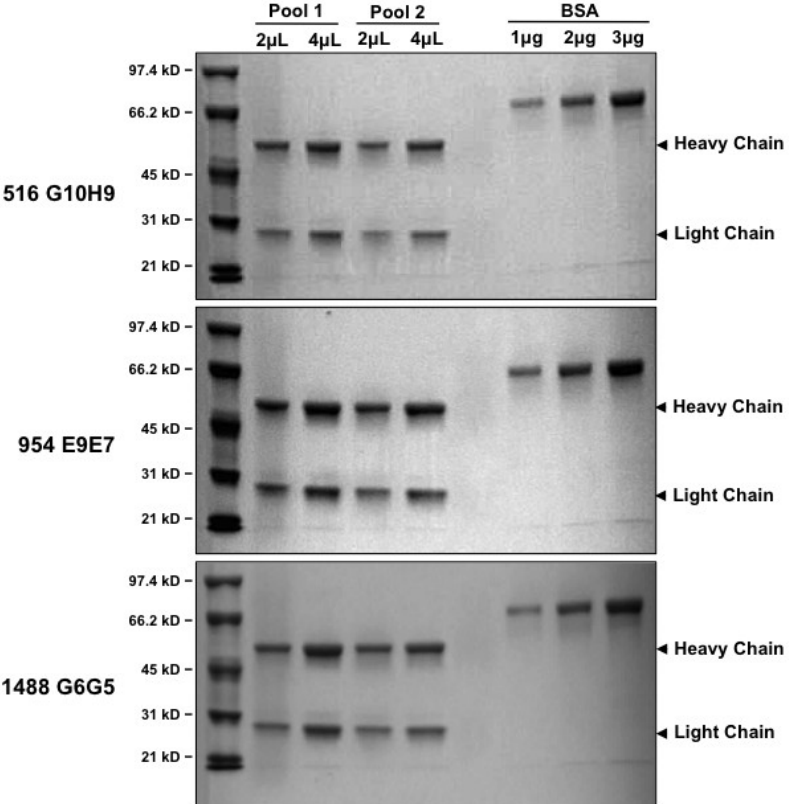
amounts (1 µg, 2 µg, 3 µg) of control protein Bovine Serum Albumin (BSA, lanes 7–9) and 516 G10H9 (upper panel), 954 E9E7 (middle panel) and 1488 G6G5 are